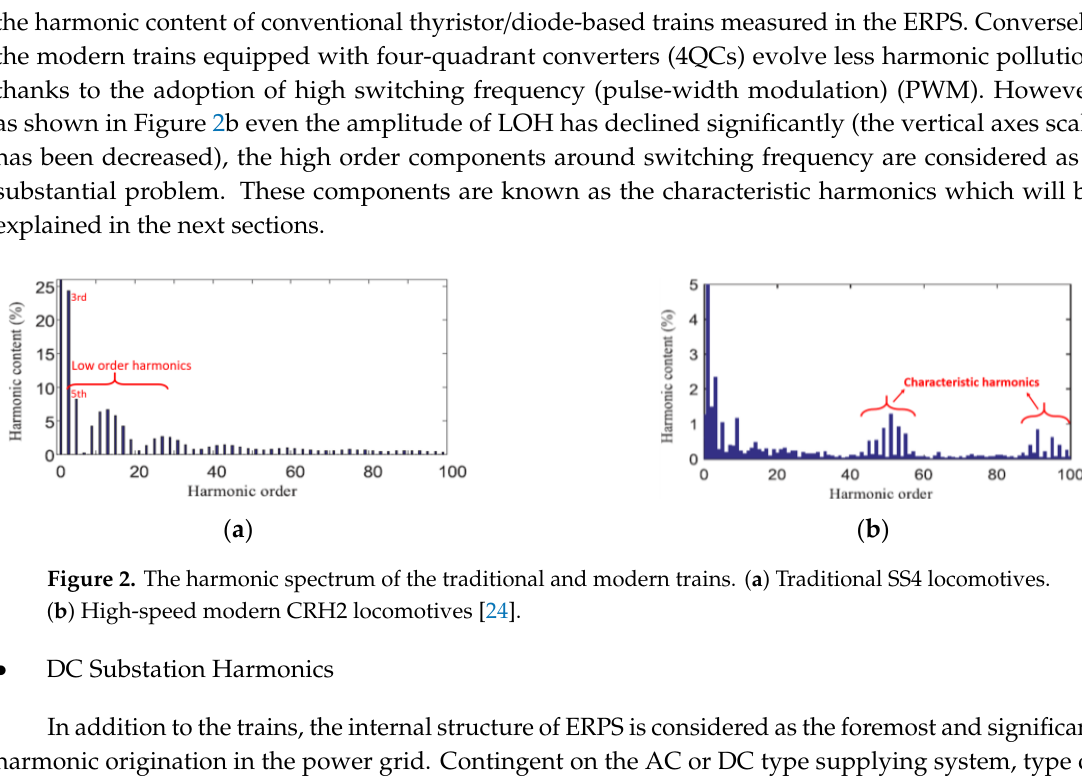
( d ) Figure 3. The primary-side current of n -pulse AC/DC converters with FFT analysis. ( a ) 6-pulse ( b ) 12- pulse ( c ) 18-pulse ( d ) 24-pulse.